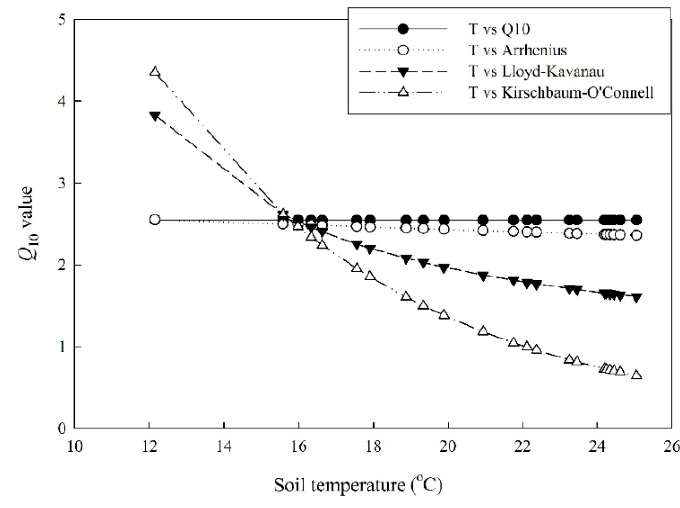
Figure 7. Soil temperature dependence of Q 10 derived using four different models.